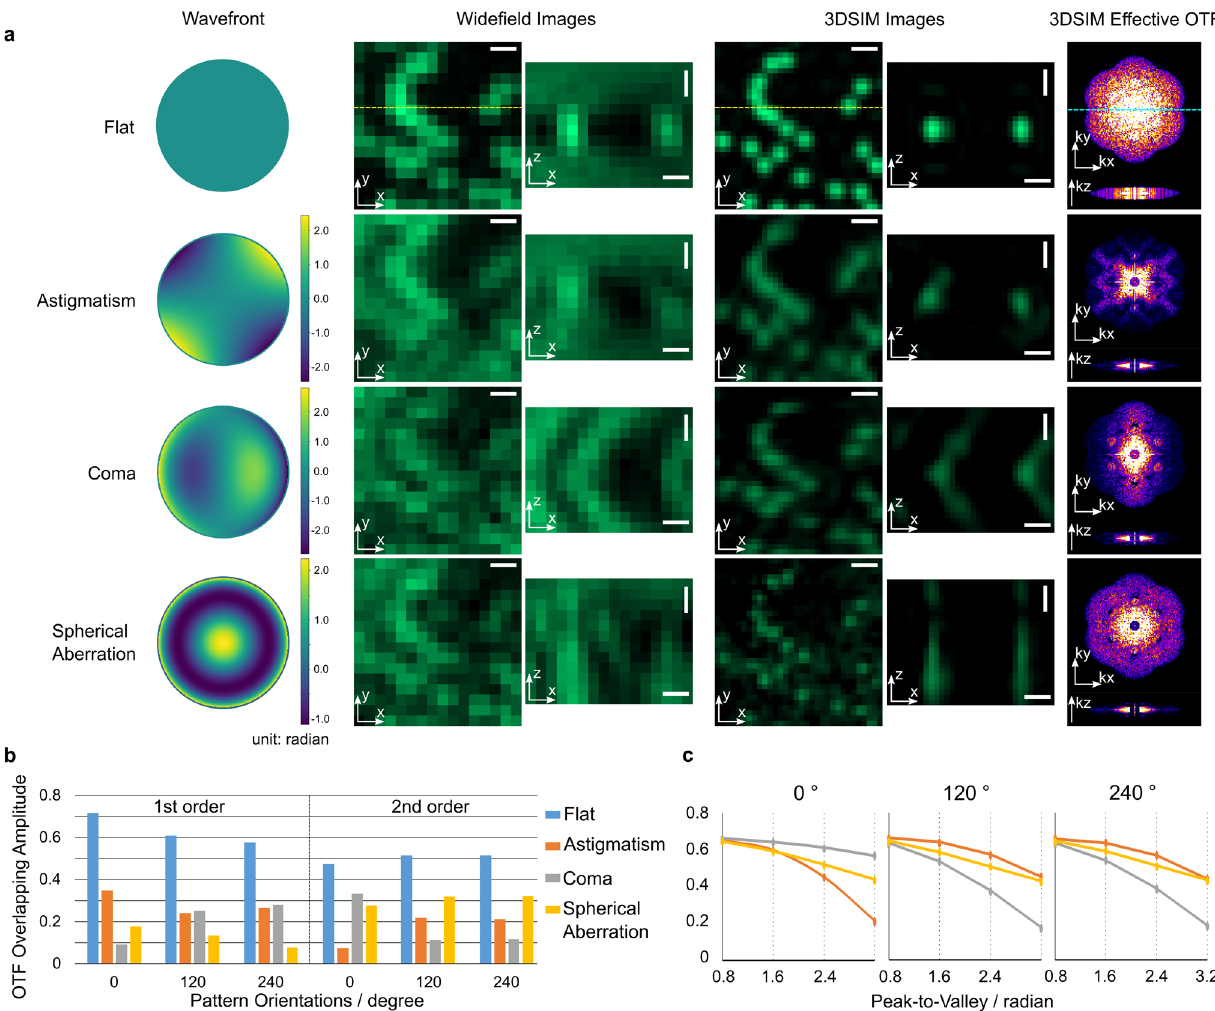
Fig. 1 Simulations of the effect of aberrations on 3D-SIM. a Four different wavefronts ( fl at, astigmatism, coma, spherical aberration) and their corresponding wide fi eld images, 3D-SIM images, and effective OTFs of the 3D-SIM images. The x-z slices are cross sections through the dashed lines in their corresponding x-y slices. The images in the same column are on the same intensity scale. All horizontal scale bars are 0.25 μ m. All vertical scale bars are 0.5 μ m. b The OTF overlapping amplitudes of the fi rst and second order frequency components computed from the images in a by our 3D-SIM reconstruction algorithm. c The OTF overlapping amplitudes of three pattern orientations (0°, 120°, 240°) for the three aberration modes (astigmatism, coma, spherical aberration) of increasing peak-to-valley wavefront errors. The OTF overlapping amplitude is the parameter in the reconstruction algorithm, which determines the pattern frequency and strength. The amplitude value reaches its maximum when the position of the shifted data, e D pattern ’ s wave